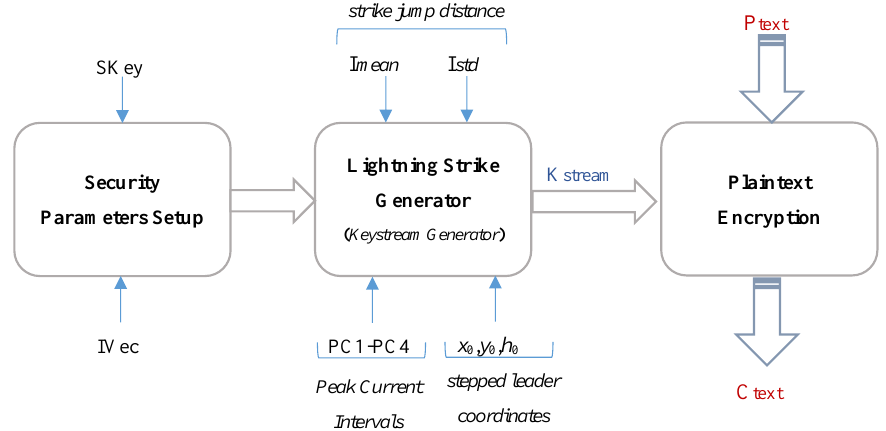
Figure 4. General structure of Strike stream cipher. Table 3. Logarithmic normal distribution of lightning current parameters.